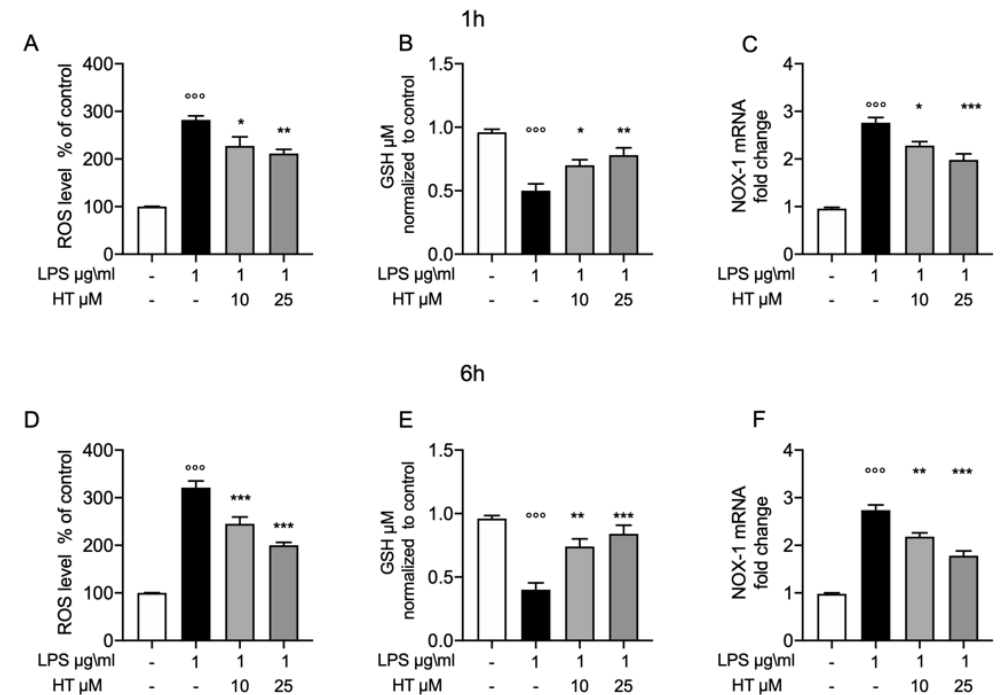
Figure 2. Protective e ff ect of hydroxytyrosol (HT) in LPS (1 µ g / mL) induced oxidative stress in MAC-T cell. ( A ) Intracellular ROS, ( B ) GSH levels and ( C ) NOX-1 mRNA levels, one hour post stimulation LPS; ( D ) intracellular ROS, ( E ) GSH levels and ( F ) NOX-1 mRNA levels, six hours post LPS. Data